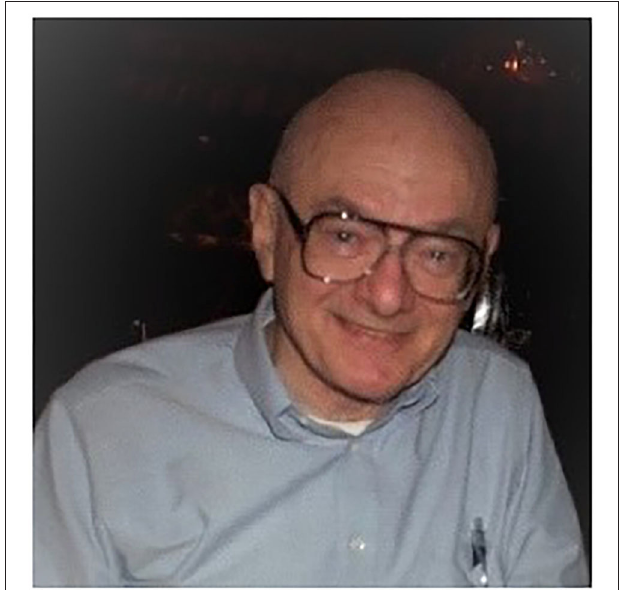
FIGURE 1 | Steven Edward Kornguth, PhD (December 1, 1935–September 21, 2020) at a professional conference in 2009. Image credit: James Ness. Written informed consent was obtained for the publication of the